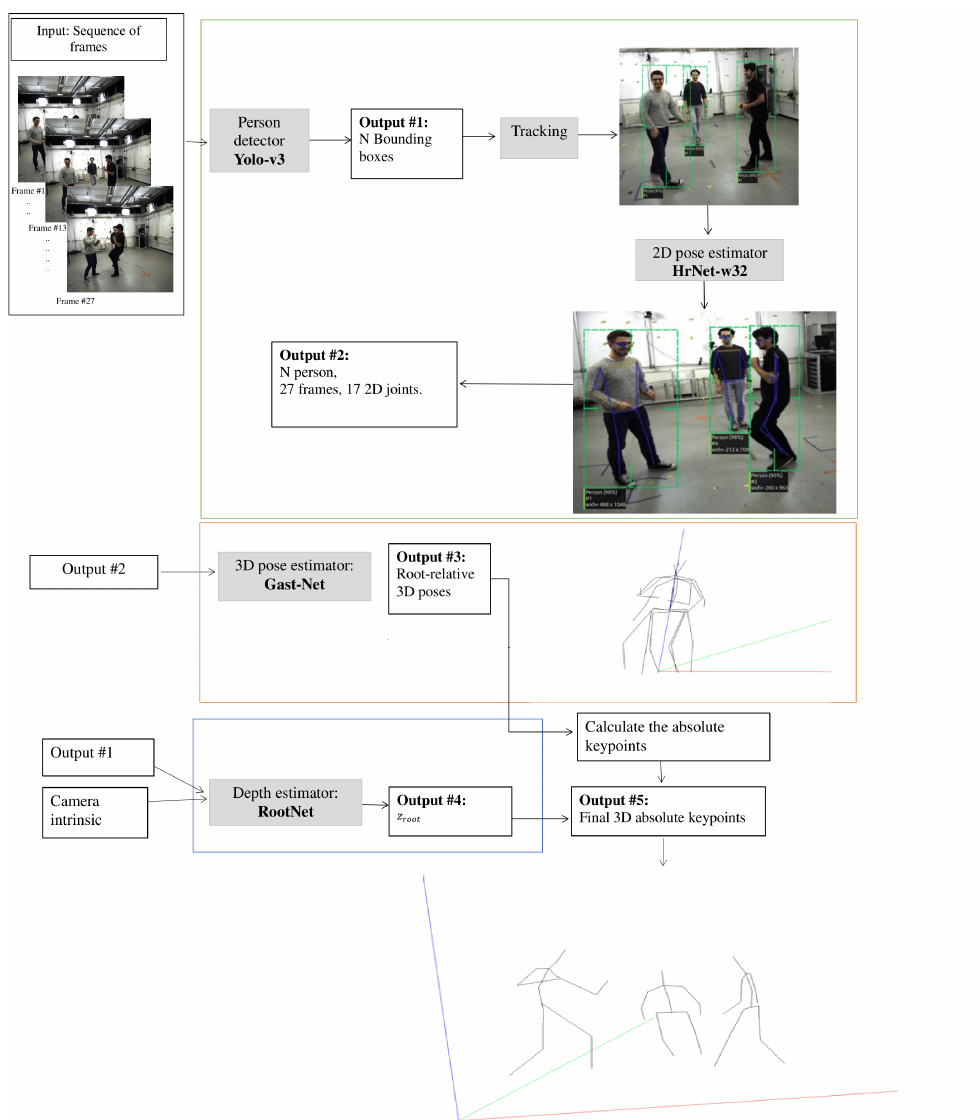
Figure 3. The pipeline of the Root-GAST-Net